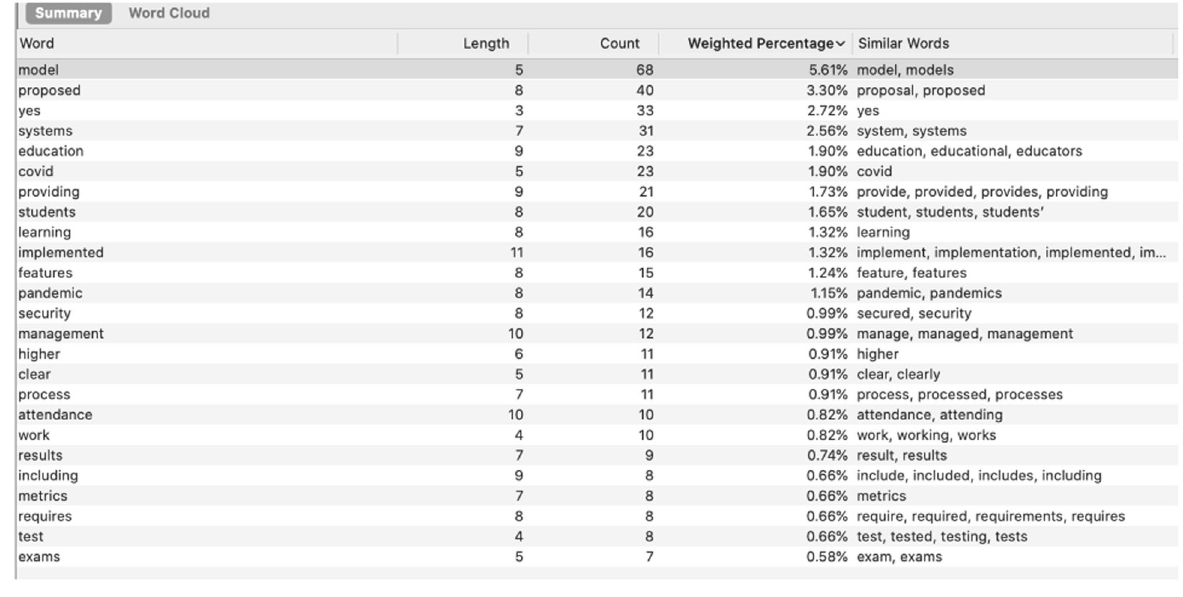
Fig. 4 Stemmed matching of top 25 most frequent words from the evaluation.